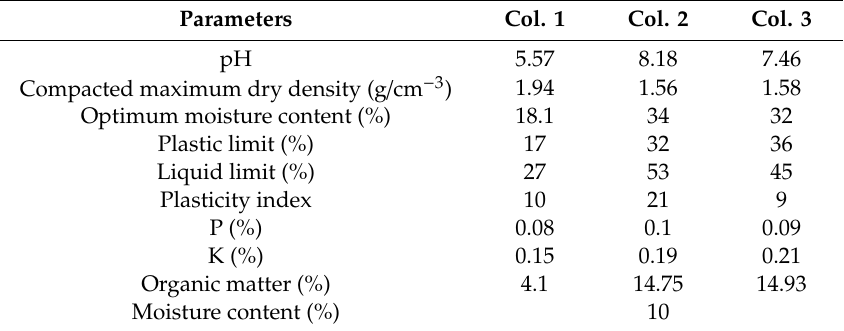
Table 2. Characteristics of three covering materials installed in the